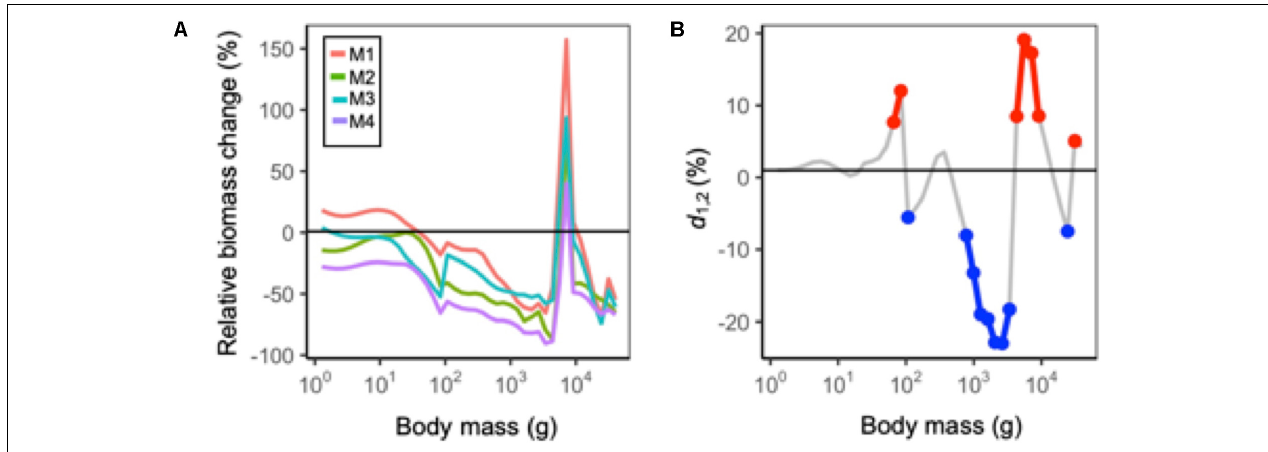
FIGURE 7 | (A) Mean size spectra in 2090 relative to historical levels under each MSSM variant. All projections are under RCP 8.5 and assuming status quo fishing. (B) Difference in the cumulative effects of natural mortality and body growth-related temperature dependency assumptions from an additive effect ( d 1 , 2 ) on abundance at each size class. Red and blue points correspond to values larger and less than 5% of the additive effect,